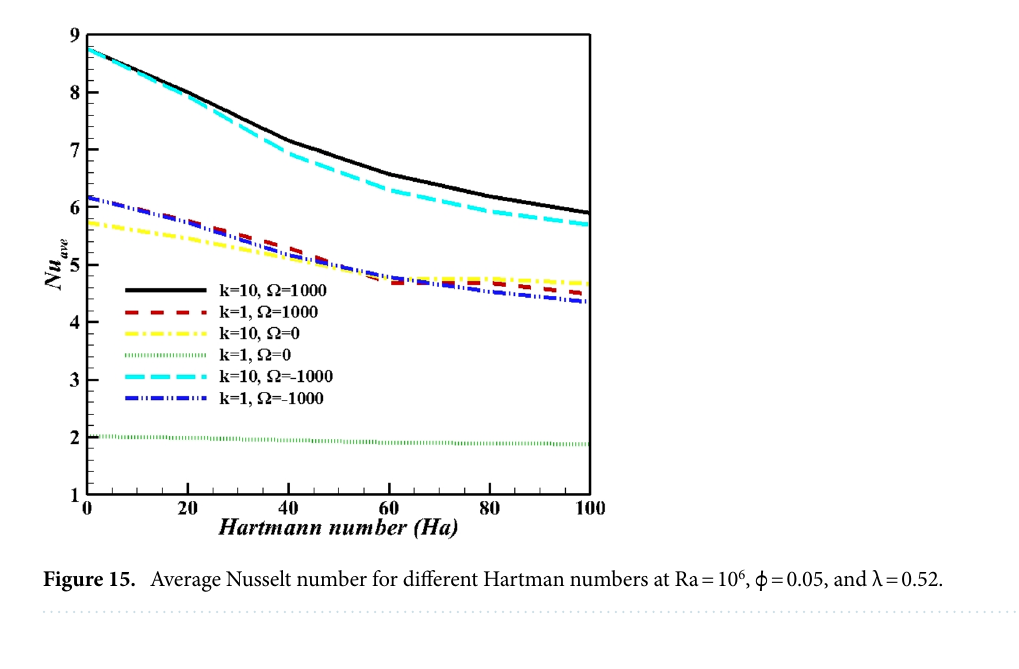
Figure 14. Local Nusselt number along contact arc for different rotationl speeds at Ra = 10 6 , Ha = 60, λ = 0.52, and